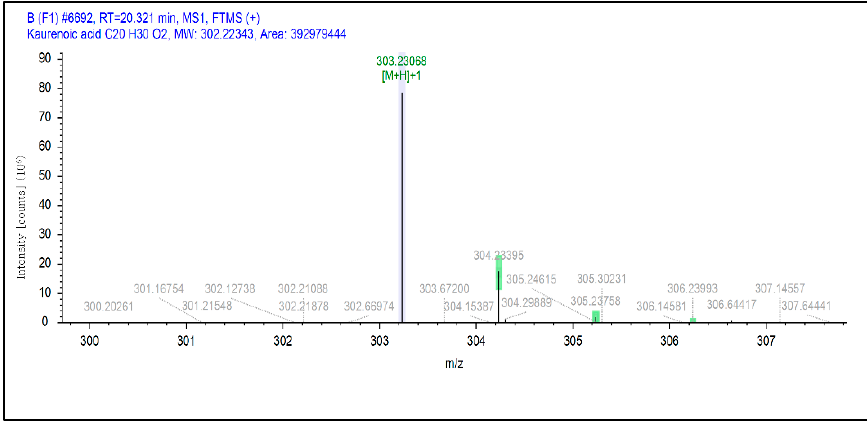
Figure 5. Selected extracted ion chromatogram of kaurenoic acid in SCE.